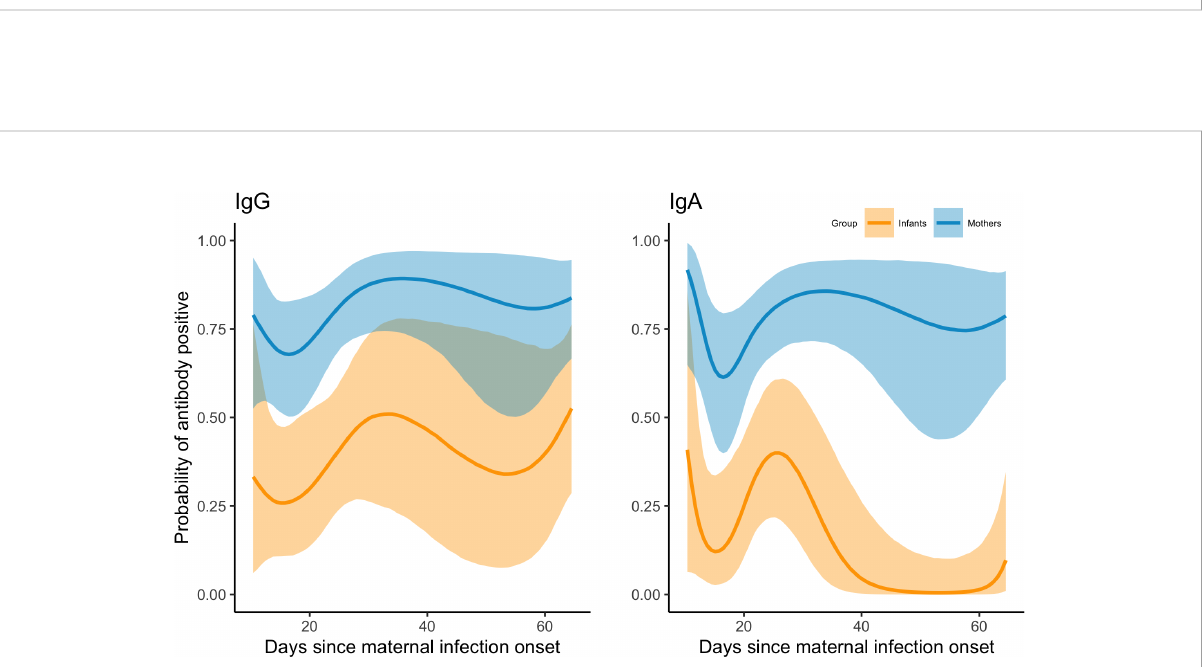
FIGURE 4 Mean estimated probabilities (95% credible intervals) of IgG and IgA seropositivity (S/CO ≥ 1) in samples collected from COVID+ mothers (n = 36, n obs = 116) and their exposed infants (n = 25, n obs = 66) in the two months following maternal infection onset.